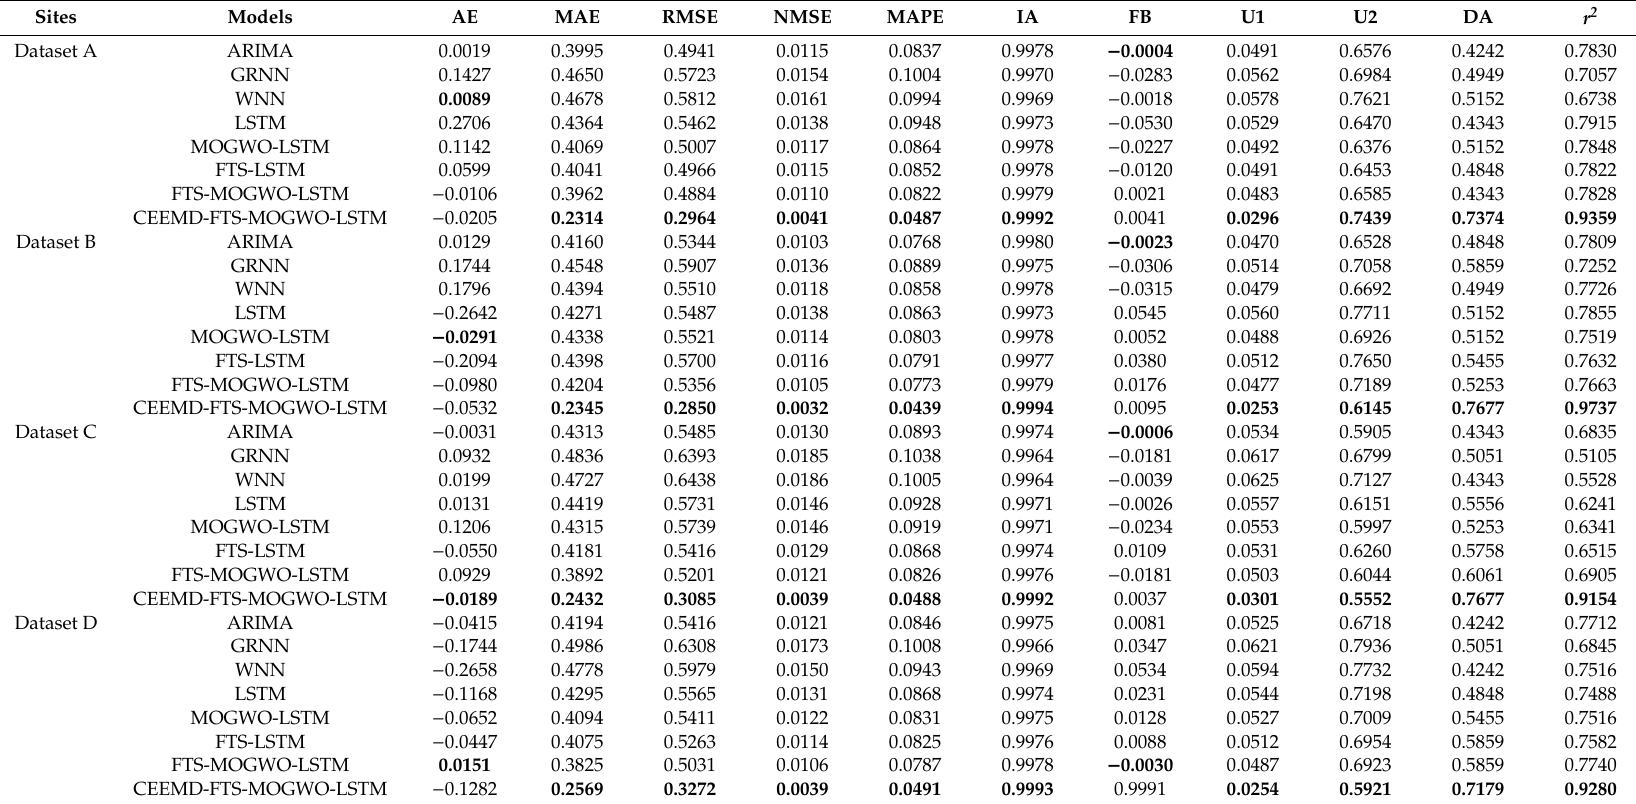
Table 7. Results of the developed forecasting framework and other models (Experiment